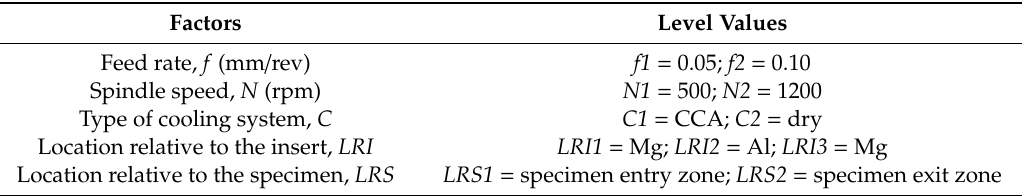
Table 4. Factors, levels, and values. CCA—cold compressed air.